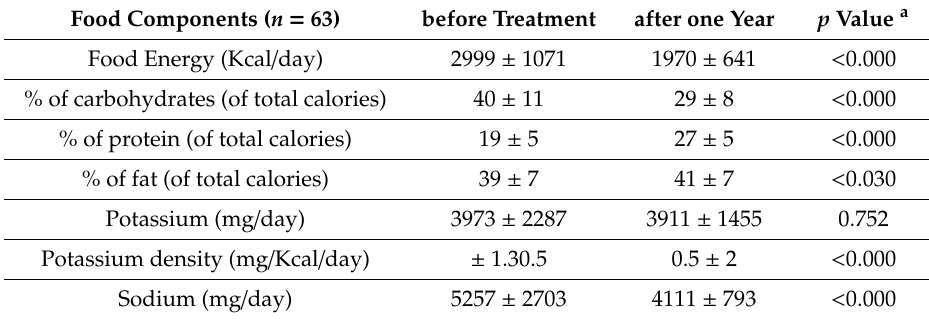
Table 2. Consumption of selected food components before the dietary intervention and after one